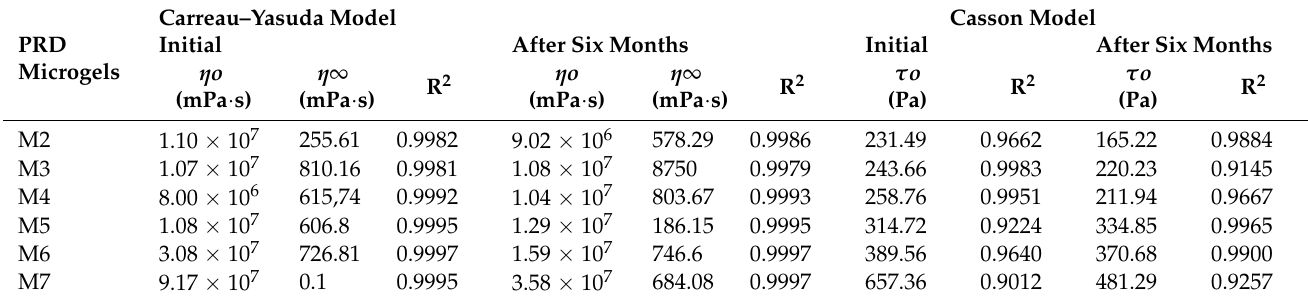
Table 7. The rheological parameters (infinite shear rates ( η o ) , infinite viscosity ( η ∞ ) , yield stress ( τ o ) , and correlation coefficient (R 2 )) of the PRD microgels obtained using the mathematical models Carreau–Yasuda and Casson.